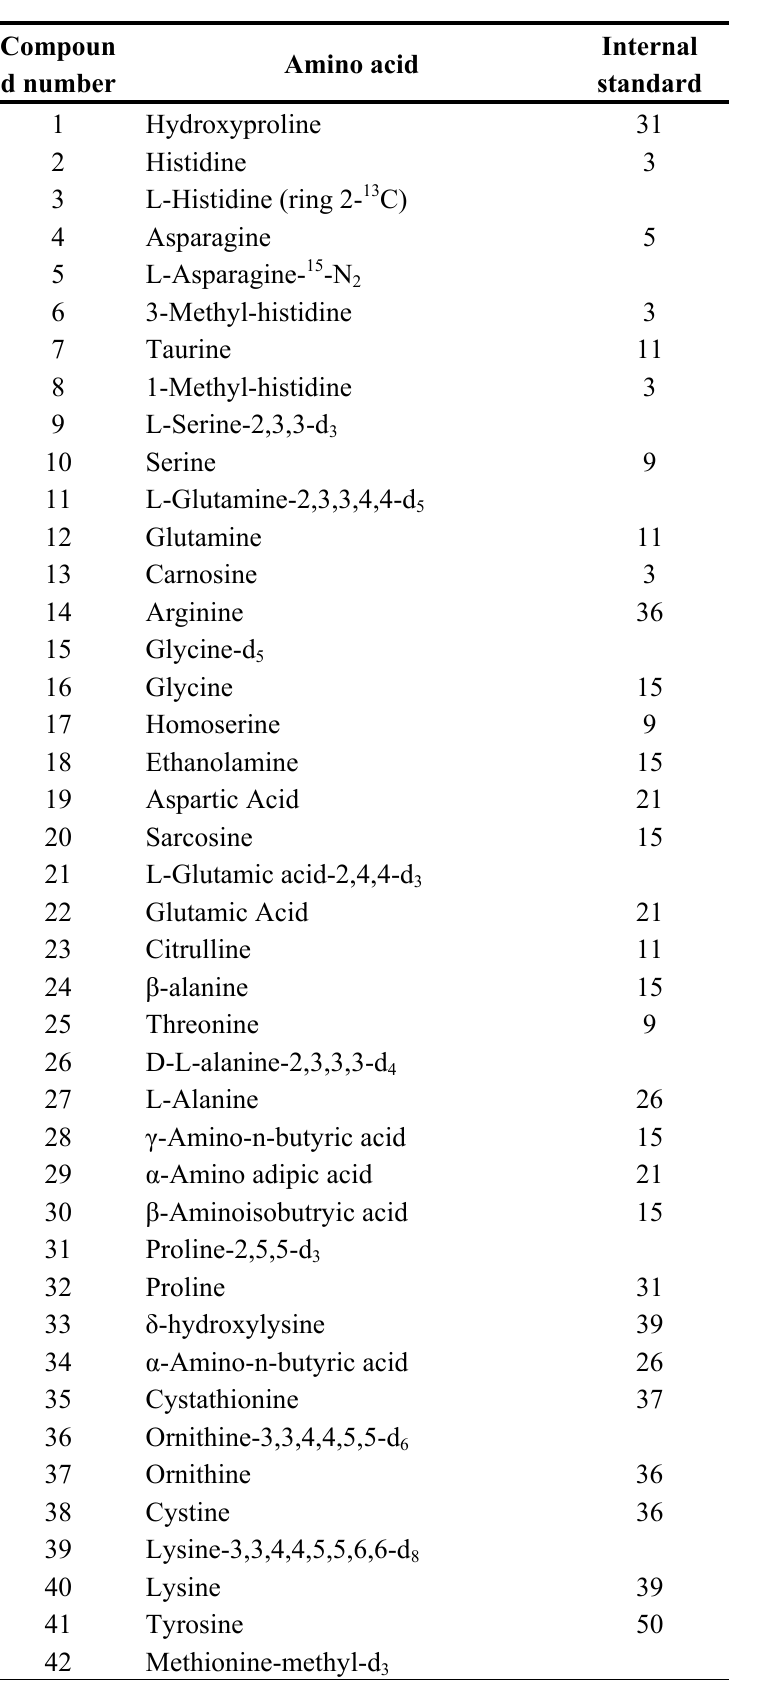
Table S3 . Assignment of internal standards for UPLC-ESI-MS/MS determination of AQC- amino acid